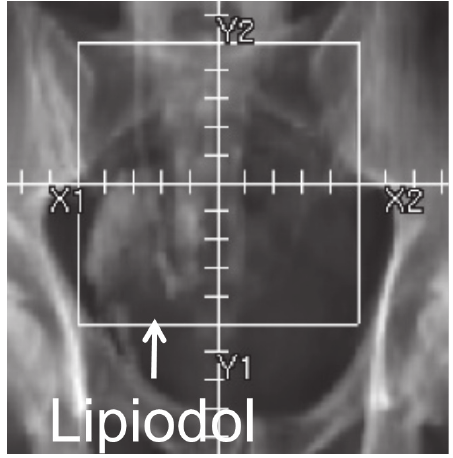
Figure 1A - Digitally reconstructed radiograph (anterior view) showing Lipiodol contrast demarcating the tumor bed in the anterior and right lateral walls of the bladder.